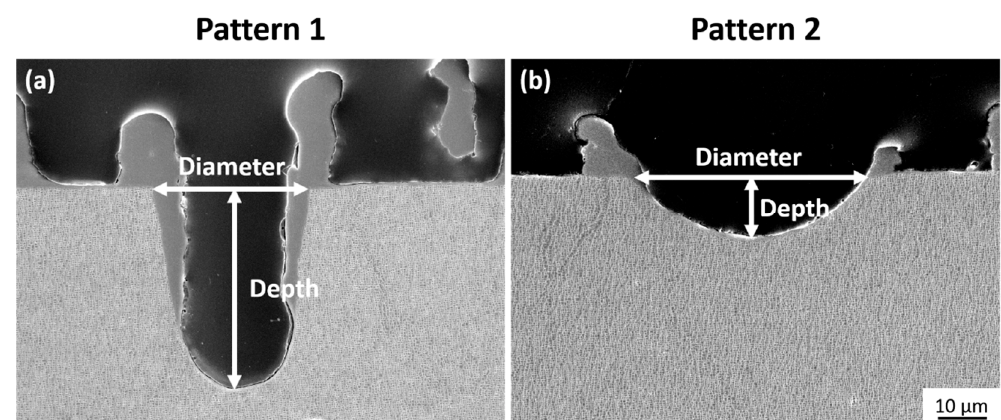
Figure 3. Dimensions considered for the thermally affected volume calculation: ( a ) pattern 1, ( b ) pattern 2.